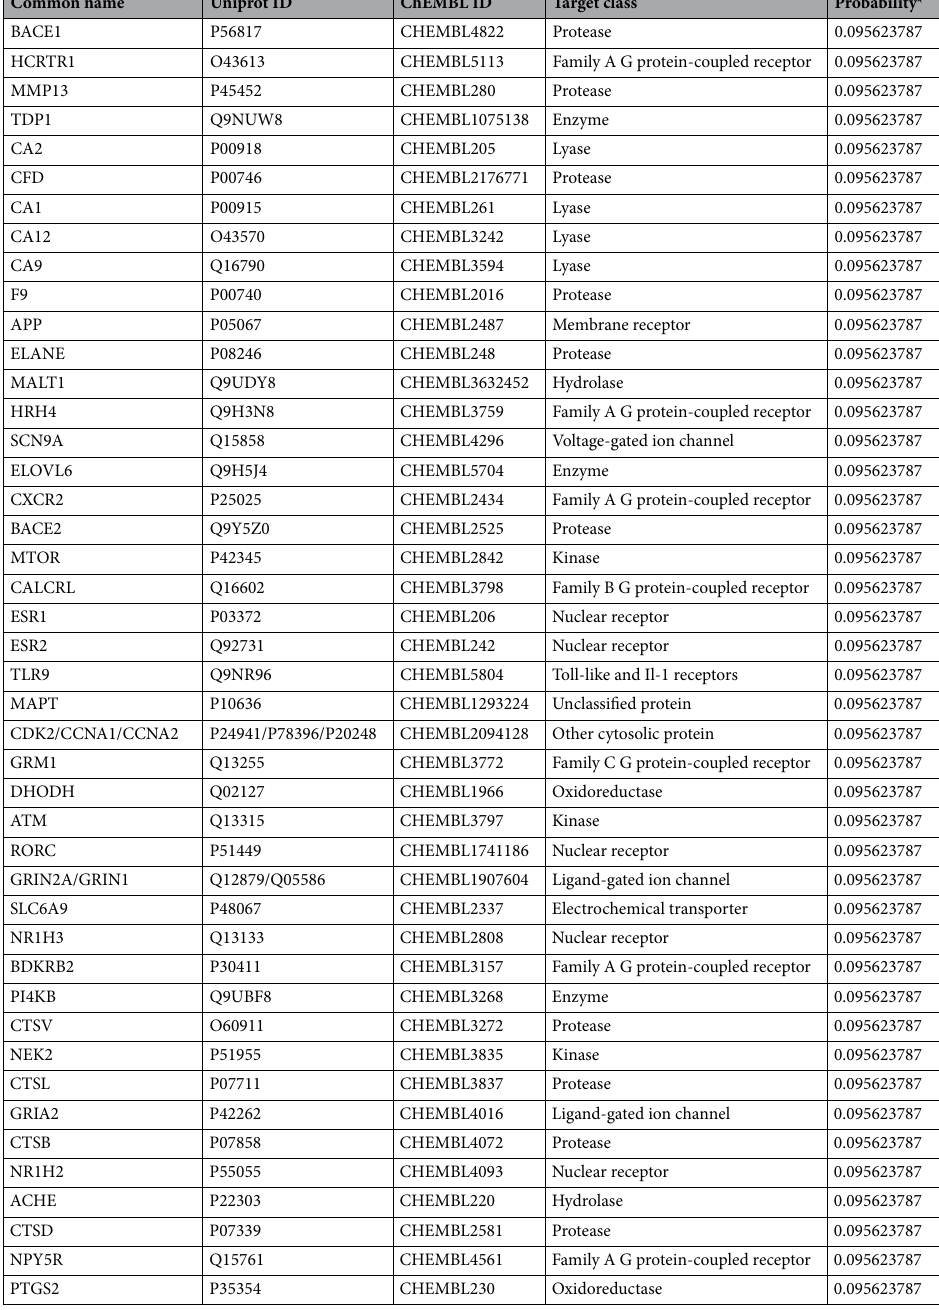
Table 1. SwissTargetPrediction analysis of the targets of